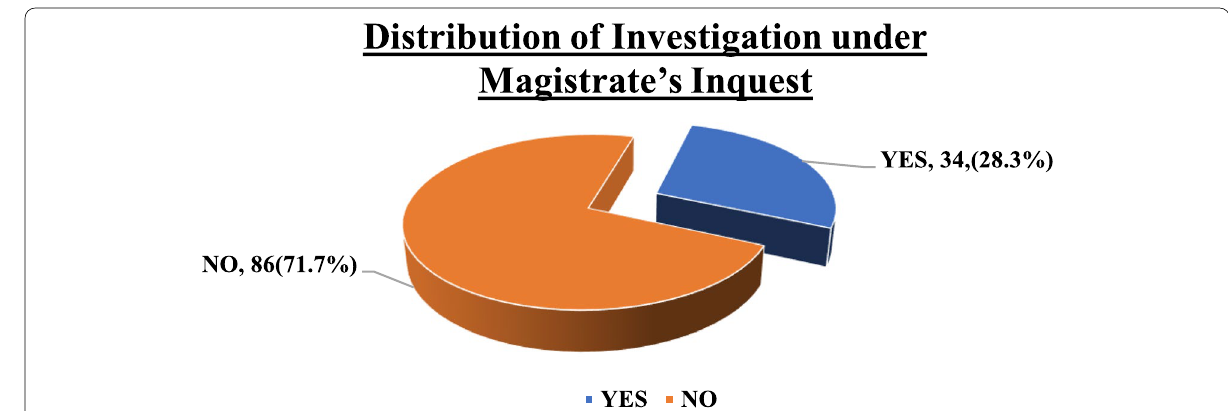
Fig. 7 Distribution of Investigation done under Magistrate’s